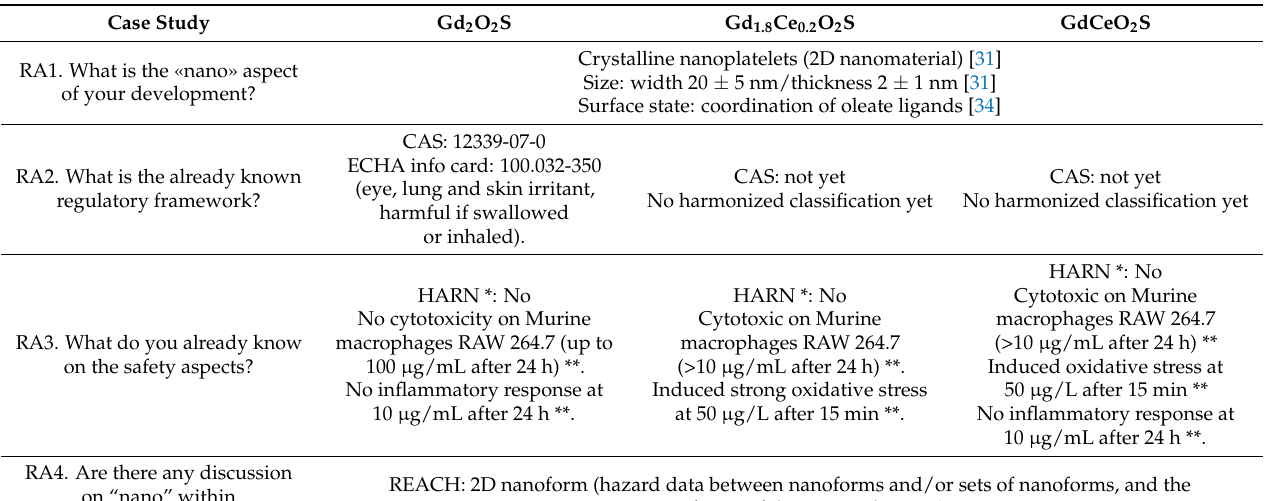
Table 1. Risk Analysis and Technology Assessment of Gd 2(1 − x ) Ce 2 x O 2 S nanoparticles inspired from [27] by applying van Wezel methodology [26] for SbD